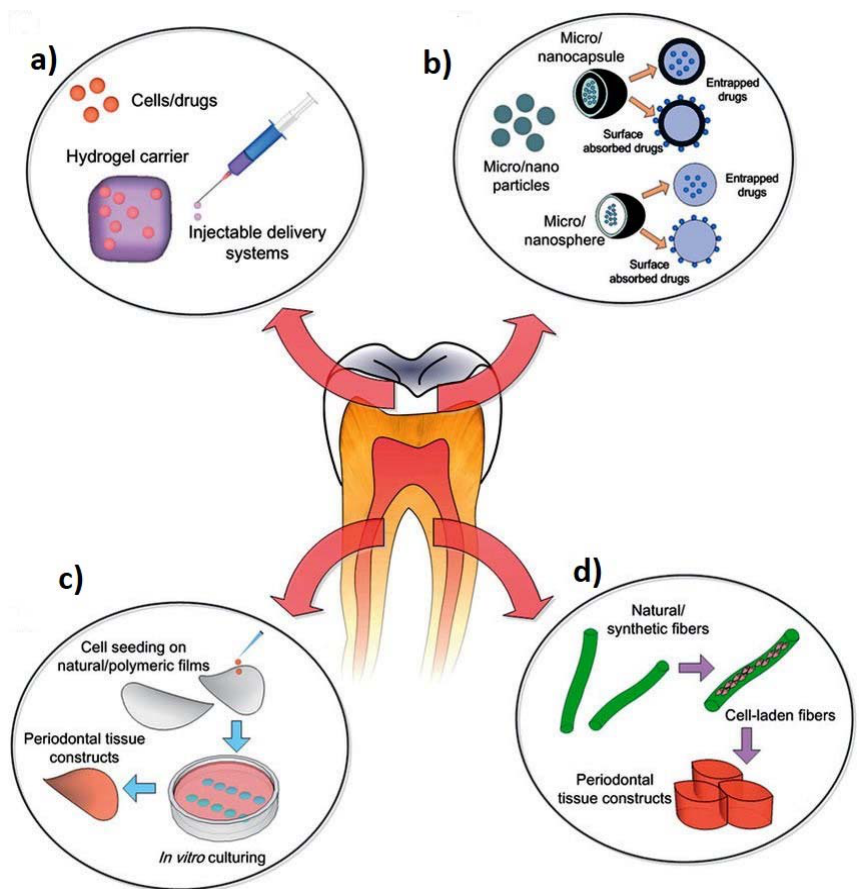
Figure 2. Schematic diagram of different biomaterials as ( a ) injectable hydrogels, ( b ) micro ‐ nanoparticles, ( c ) natural polymers seeded with periodontal ligament (PDL) cells and ( d ) natural/synthetic scaffolds for periodontal disease treatment. Reprinted from [70] with permission from Taylor & Francis Online.